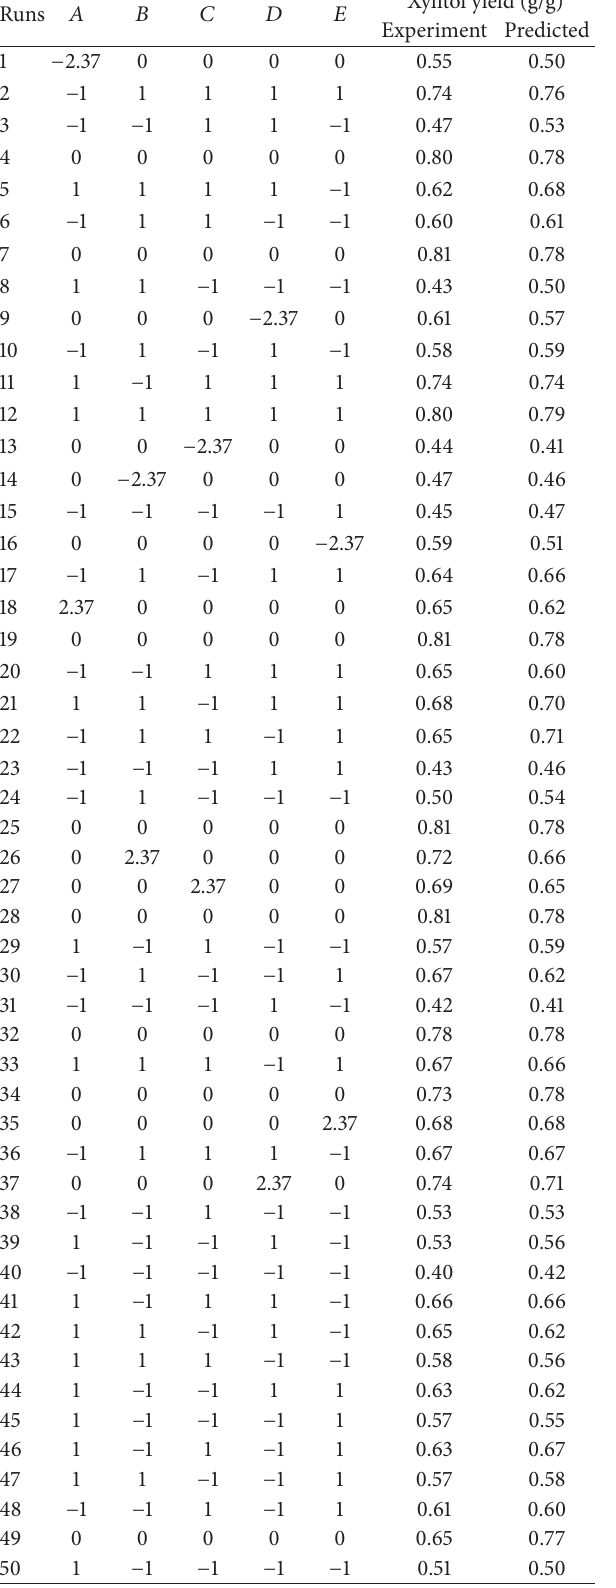
Table 6: Central composite design (CCD) in coded levels with xylitol yield as response.